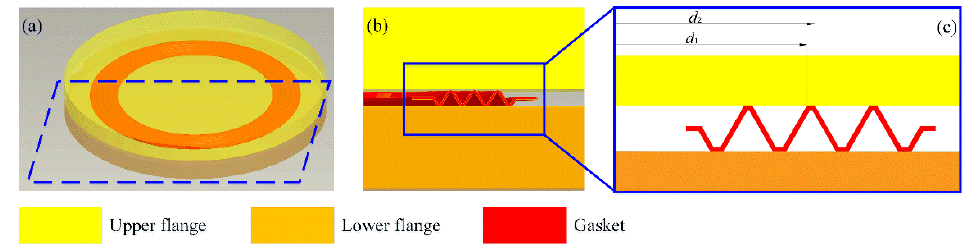
Figure 1. Schematic diagram of corrugated gasket seal: ( a ) corrugated gasket and flangs, ( b ) sec- tion of corrugated gasket, ( c ) partial enlarged detail. of corrugated gasket, ( c ) partial enlarged